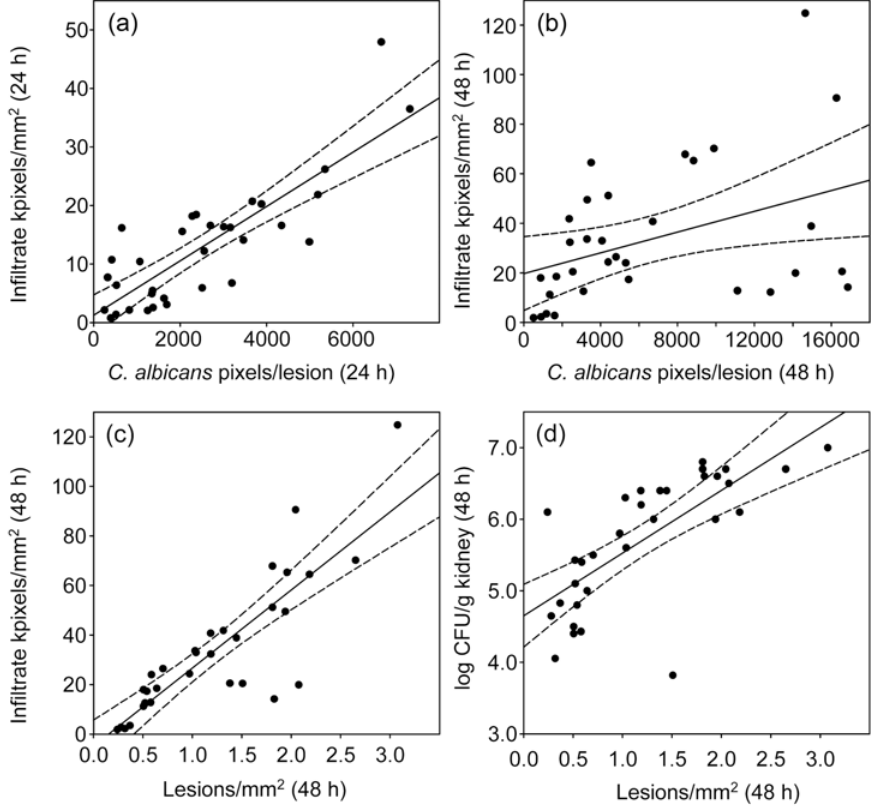
Figure 3. Scatterplots of lesion parameters. Each point represents the result for a single animal, with 3 animals per C. albicans isolate. In each figure the solid line is the regression line and the dashed curves indicate the 95% confidence region. (a) Lesion density (48 h) vs. C. albicans kidney burdens (48 h). (b) Lesion density (48 h) vs. infiltrate density(48 h). (c) C. albicans pixel density (24 h) vs. infiltrate pixel density (24 h). (d) C. albicans pixel density (48 h) vs. infiltrate pixel density (48